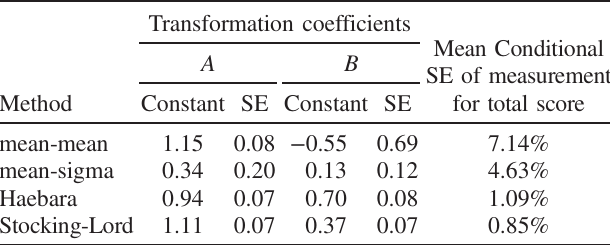
TABLE VII. Score conversion between the BEMA and CSEM using the Stocking-Lord